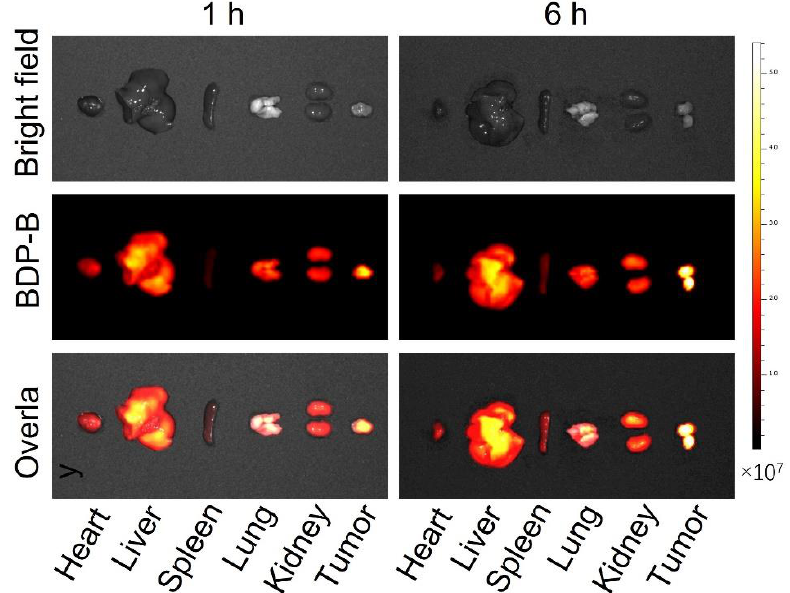
Figure 6. In vitro imaging of abdominal organs.